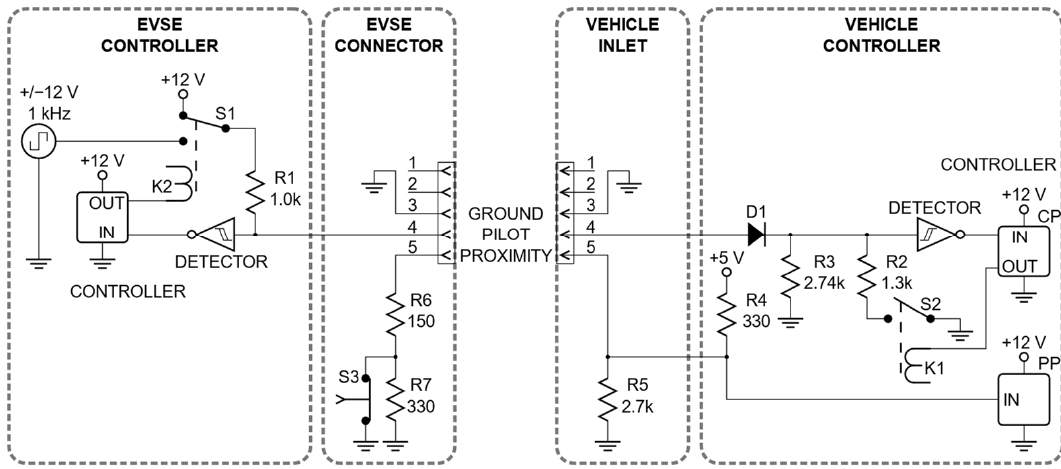
Figure 13. Signaling circuit in a J1772 interface.